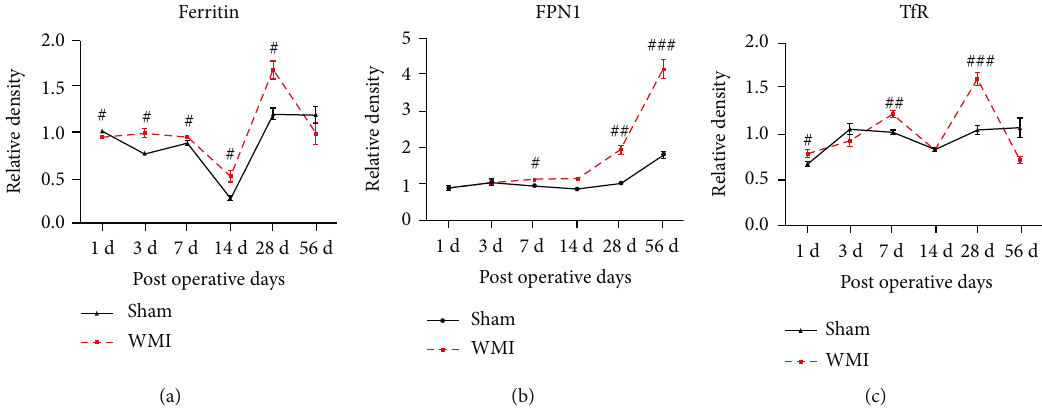
Figure 4: Changes in the expression of ferritin, FPN1, and TfR in brain tissue over time ( # p < 0 : 05 , ## p < 0 : 01 , and ### p < 0 : 01 vs. sham group, n = 4 ).